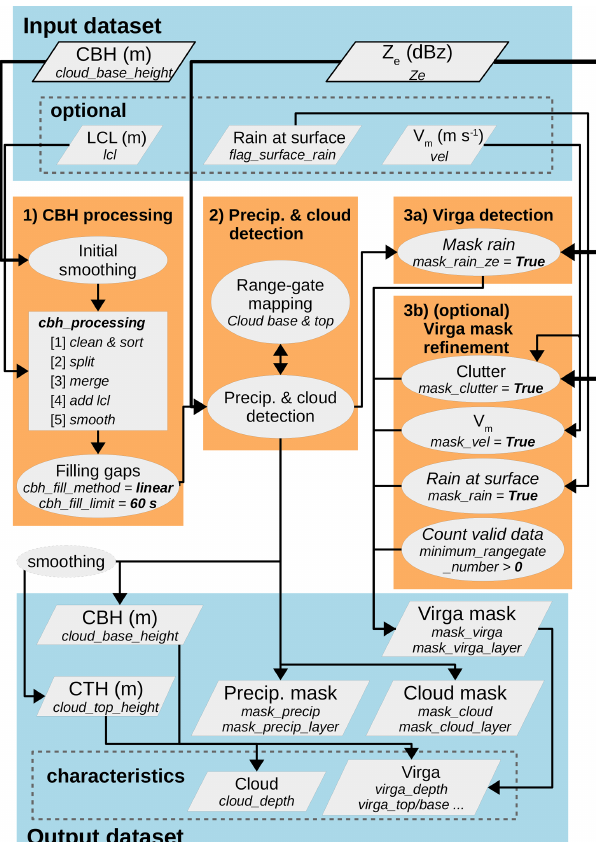
Figure 2. The workflow of the Virga-Sniffer virga detection. Data sets are shown as polygons and applied methods as ellipses. The submodule cbh_processing is shown as a square, listing imple- mented methods. Z e and V m refer to the radar variables reflectivity and mean Doppler velocity, respectively. The arrows show the data flow within the Virga-Sniffer. The data are processed from the input data set step by step, starting with (1) CBH processing, until they are stored in the output data set. Flags to enable certain virga mask refinements are denoted in italics with their default